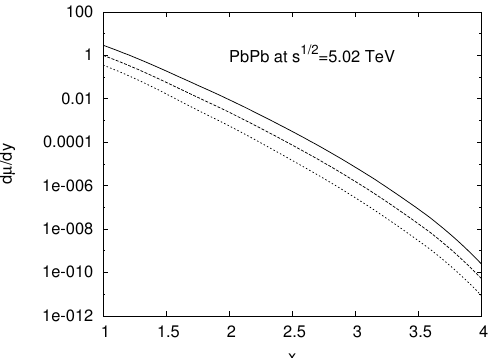
Figure 8. Multiplicities per unit rapidity for production of cumulative pions at cumulativity x ≥ 1 in the central (upper curve), mid-central (middle curve), and peripheral (lower curve) regions in Pb–Pb collisions at 5.02 TeV.